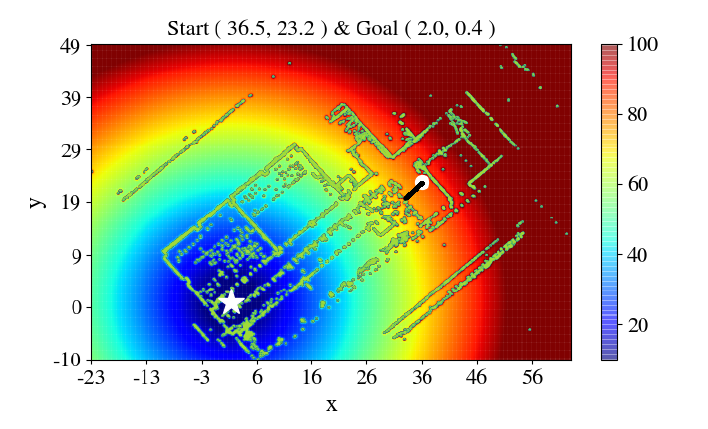
Figure 16. Non-discretized potential map—failed scenario.